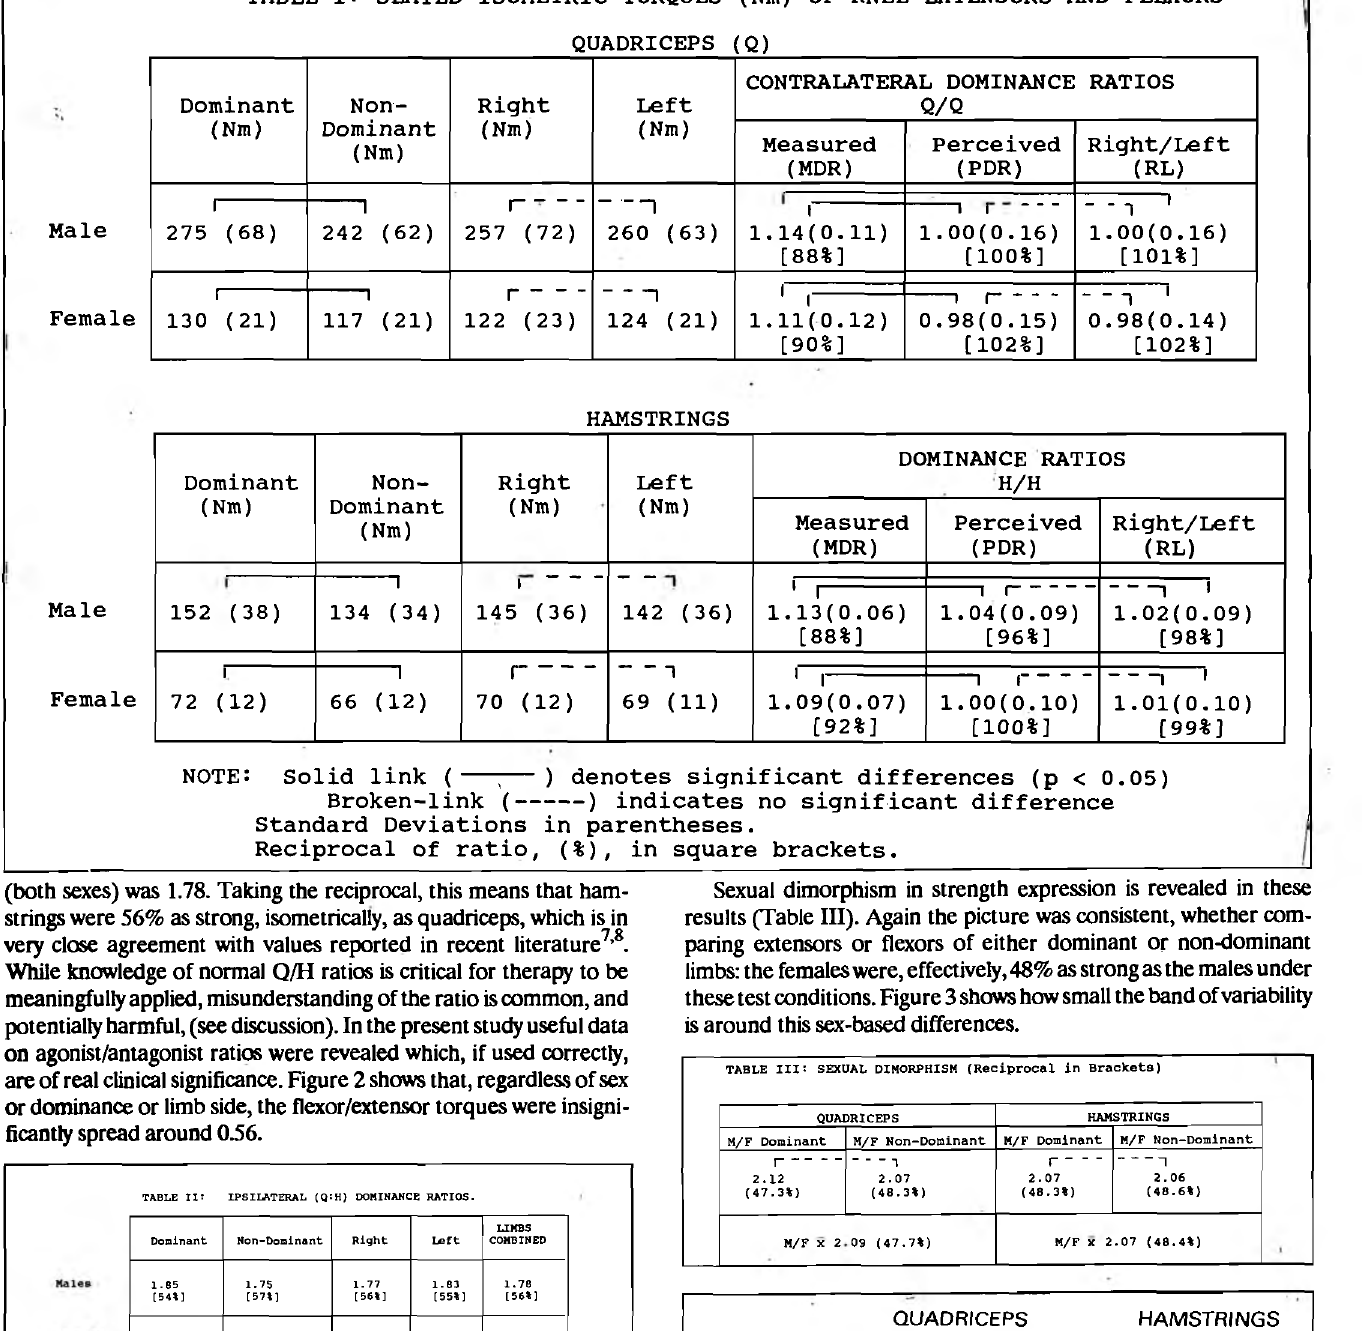
FIGURE 3: Deviation of mean values in Sexual Dimorphism of isometric torque. Mean female/male (F/M) ratio is depicted as a horizontal band. Vertical bars show domi­ nant (D) and non-dominant (N) mean deviations for quadriceps and hamstrings.